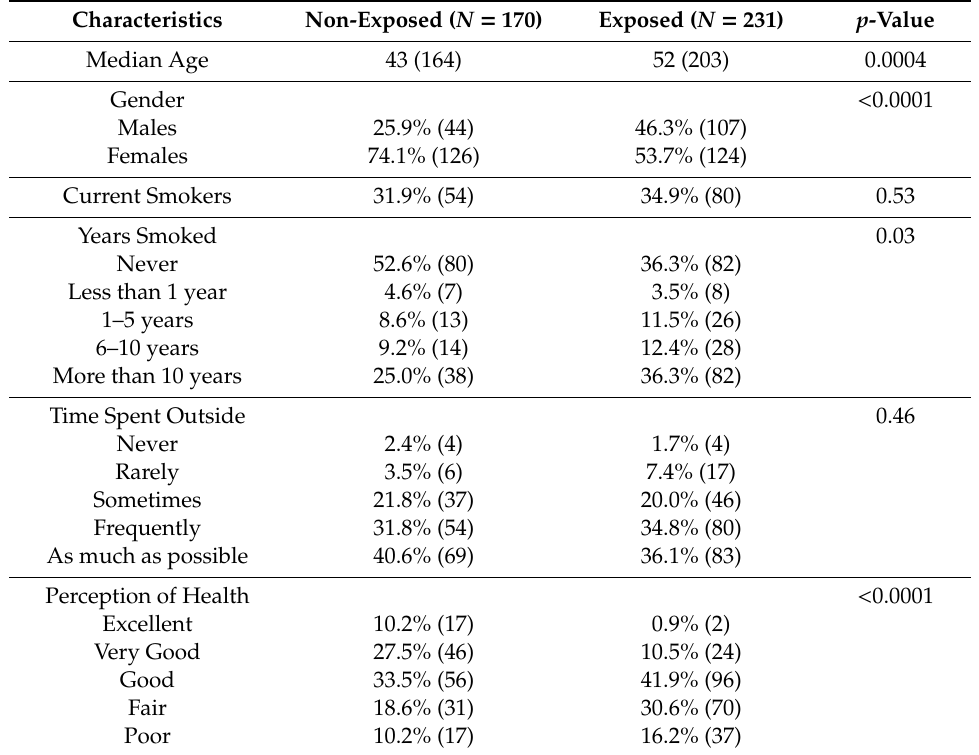
Table 1. Characteristics among the non-exposed and exposed